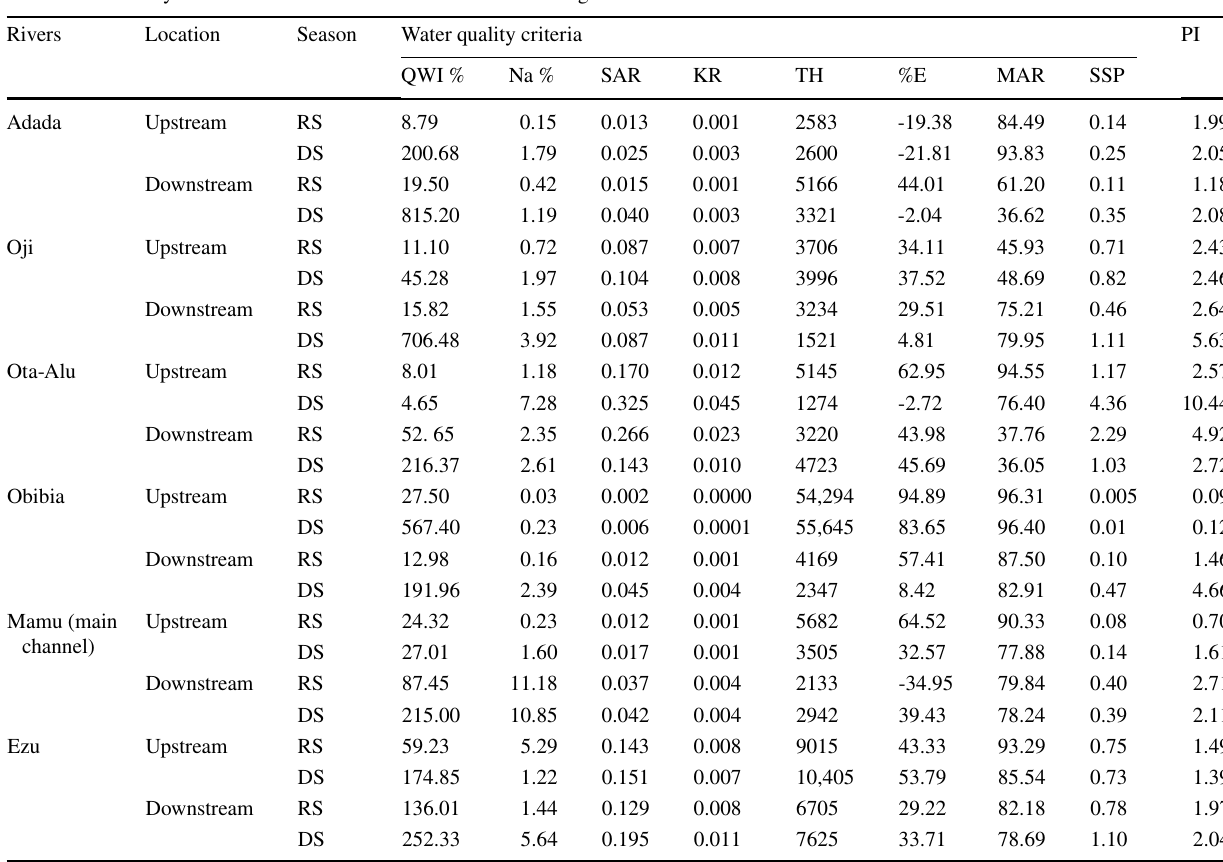
Table 10 Summary of evaluation results of different indices for irrigation water